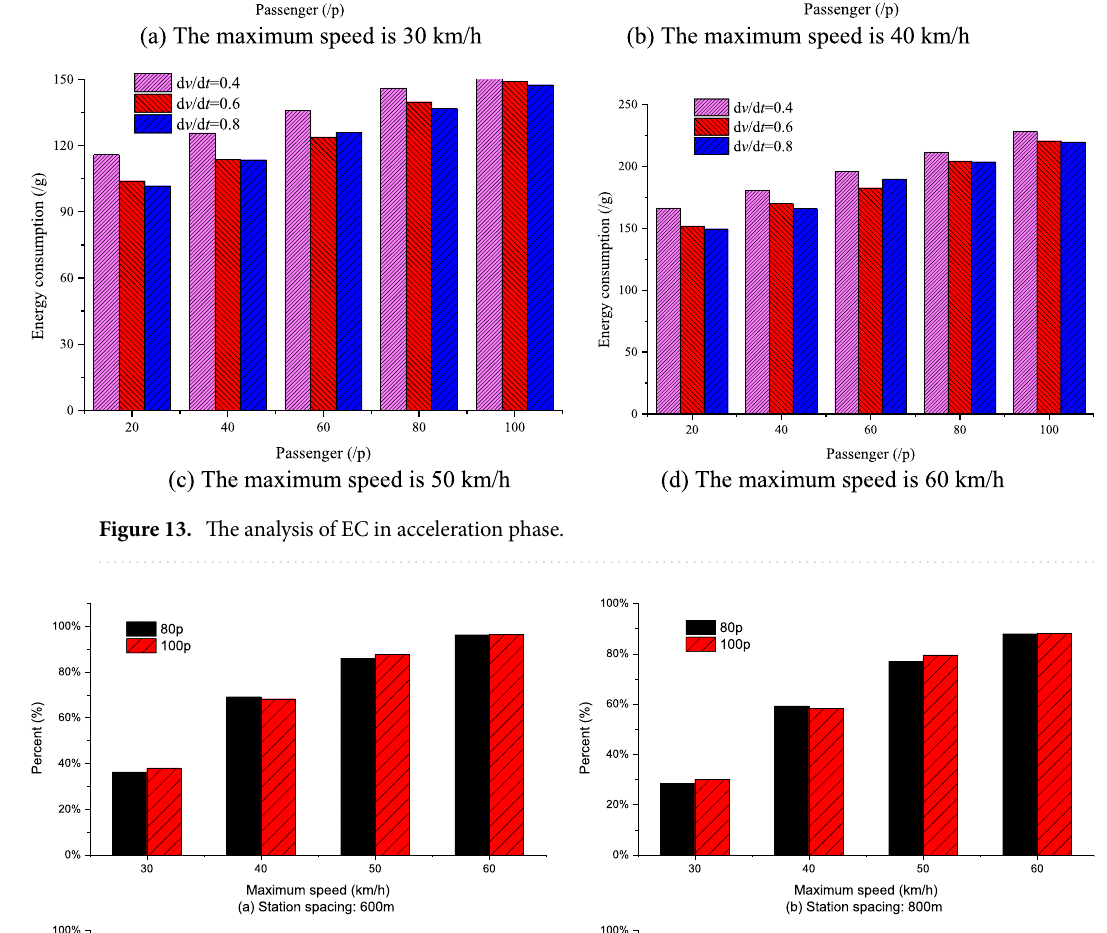
Figure 14. Analysis of the contribution percentage of EC increase in the acceleration phase at d